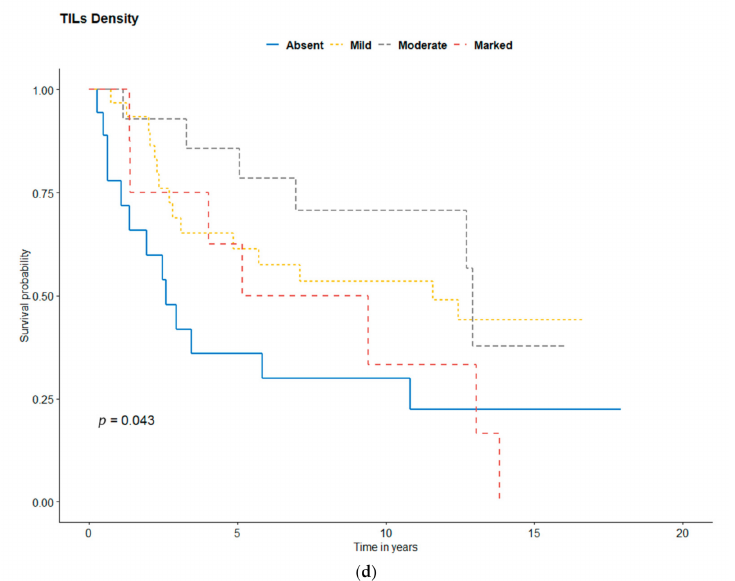
Figure 3. Kaplan-Meier survival curves for ( a ) TILs Clark: Absent/non-brisk vs. brisk, ( b ) TILs MIA grade, ( c ) TILs MIA distribution, and ( d ) TILs MIA density.